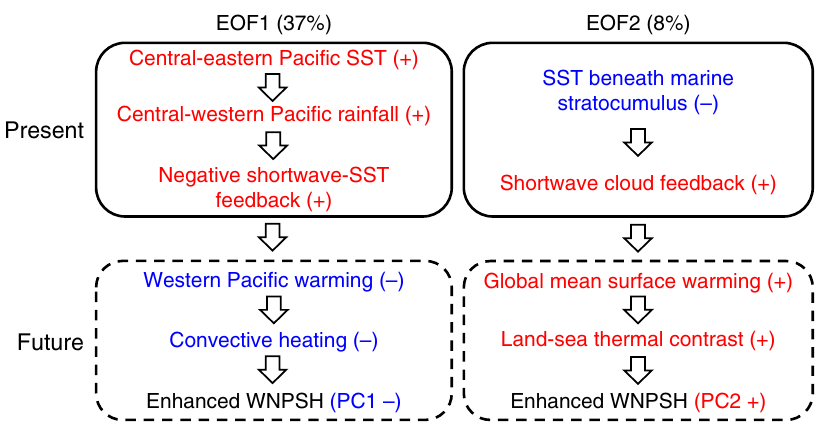
Fig. 7 Physical processes backing emergent constraints on uncertain modes. Solid boxes denote processes in the historical period and dashed boxes for future projection. Red: a process is larger/stronger in observation than historical simulation in multi-model ensemble mean (MME) or it should be larger/ stronger in future changes than original projection in MME. Blue: opposite to the red. Percentages on the top are reduced variances after constrained by observational sea surface temperature (SST) for the two leading intermodel empirical orthogonal function (EOF) modes (EOF1 and EOF2) of projected changes in the western North Paci fi c Subtropical High (WNPSH). The constrained results for both the two modes favor an enhanced western North Paci fi c Subtropical High in future, represented by a negative value of the fi rst principal component (PC1) and a positive value of the second principal component